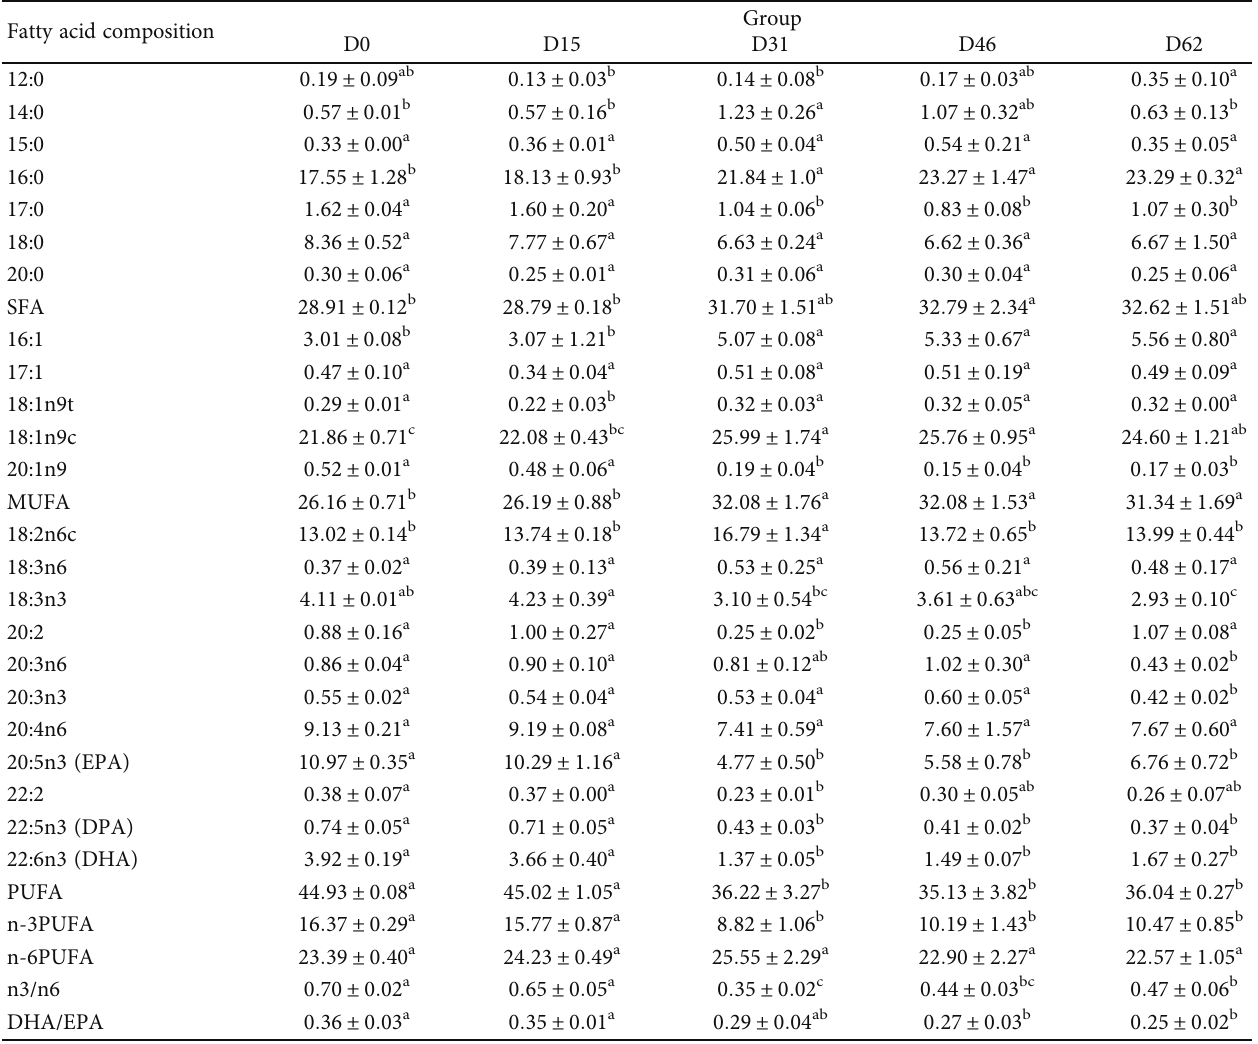
Table 7: Fatty acid composition of female E. sinensis muscle in rice-crab coculture system at di ff erent developmental periods (% dry weight). Group Fatty acid composition D0 D15 D31 D46